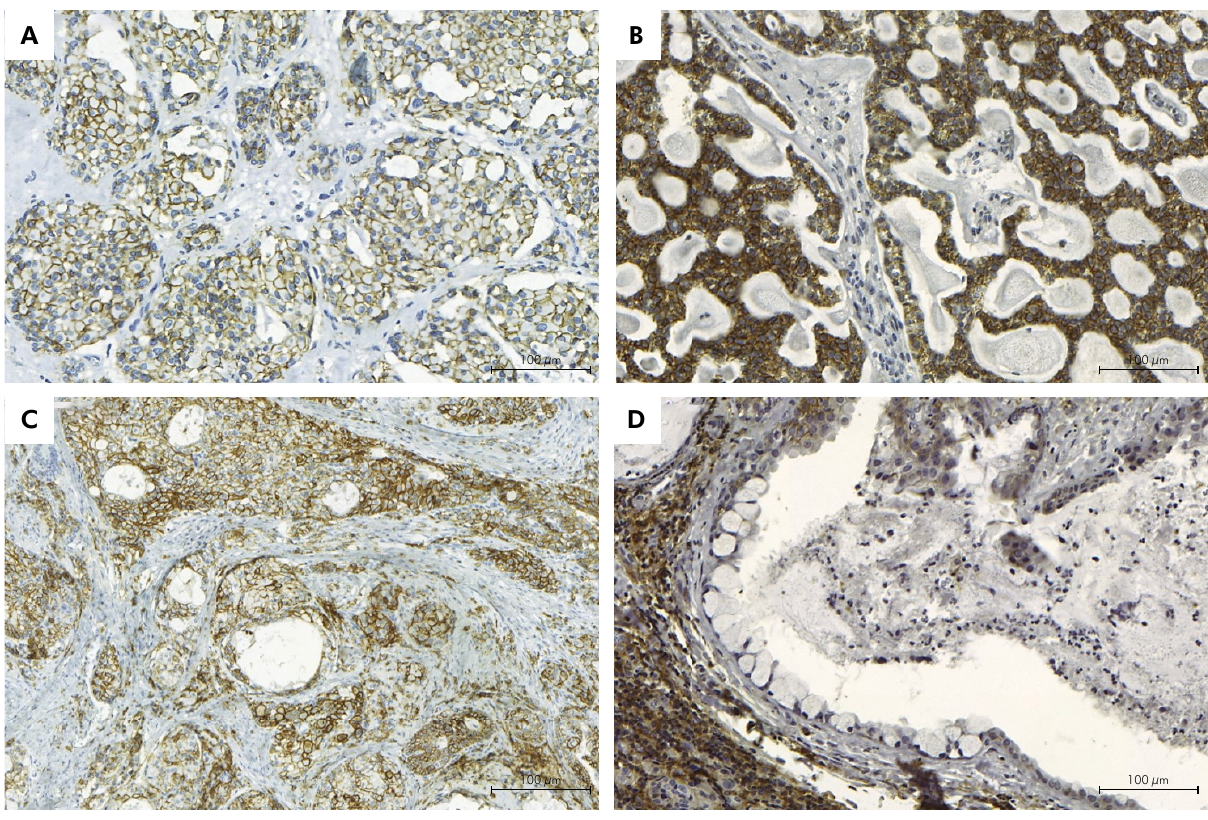
Figure 2. Immunohistochemical reactivity for CD44 in PA (A), CAC (B), and MEC (C) and absence of expression of CD44 in mucous cells of MEC (D). Panoramic Viewer, Envision.